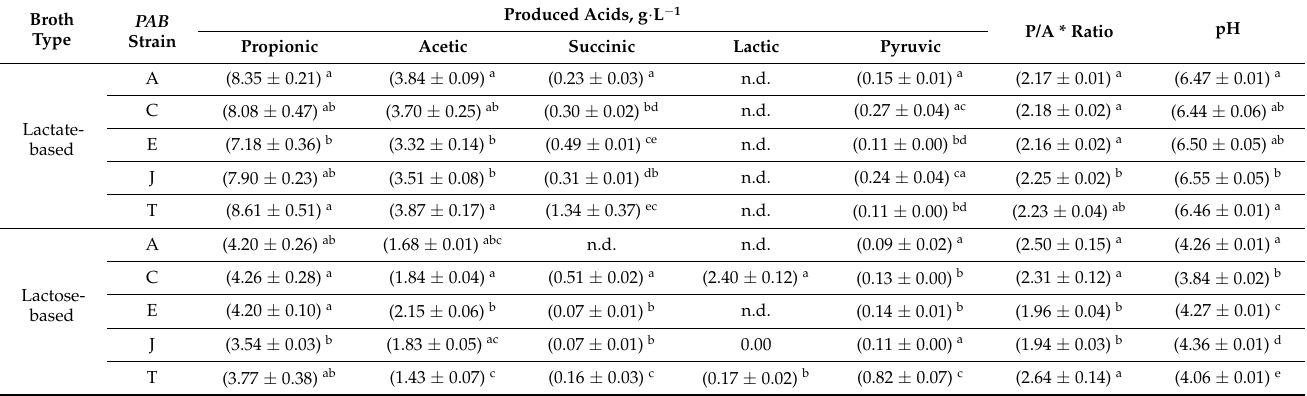
Table 2. The concentration of organic acids and pH of propionic acid bacterial